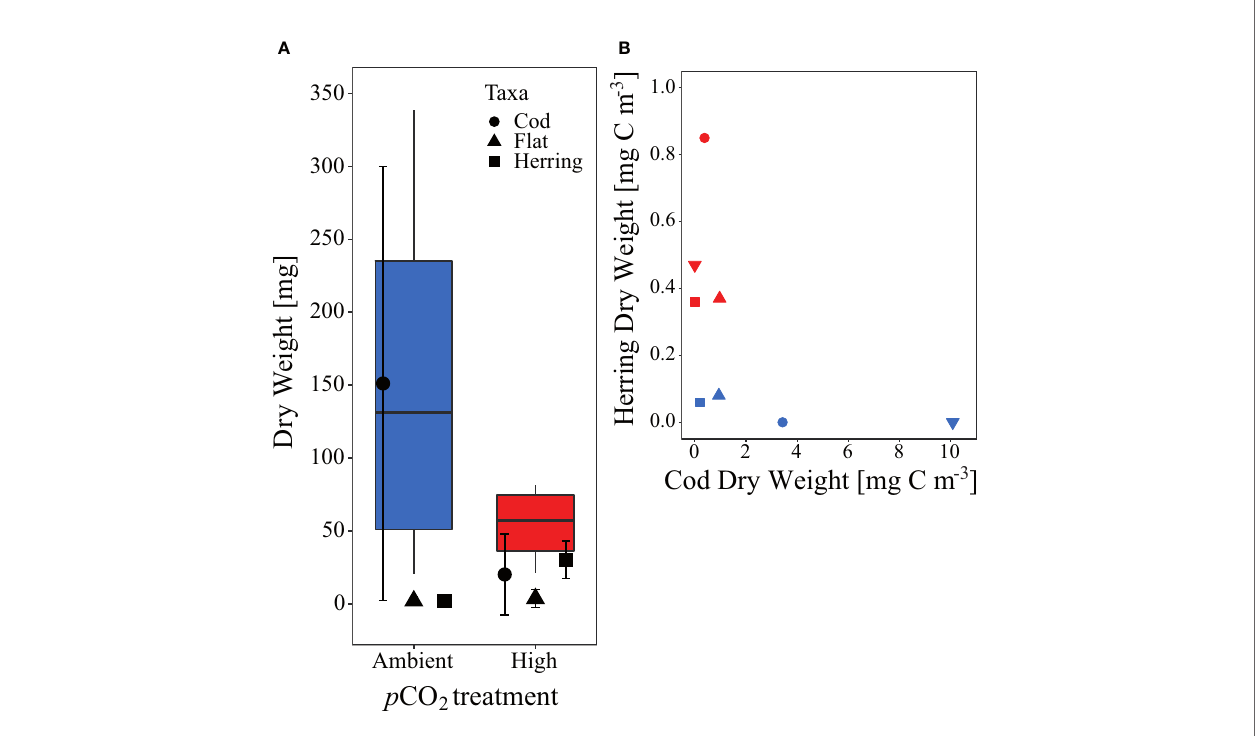
FIGURE 8 | (A) Dry weight (DW, mg) sum and contribution of all fi sh larvae caught at the end of the experiment per p CO 2 treatment. Symbols according to given legend. (B) Comparison of herring larvae and cod DW [mg C m -3 ] at the end of the experiment. Symbols and colors used for (B) are as described in Figures 1C , 2